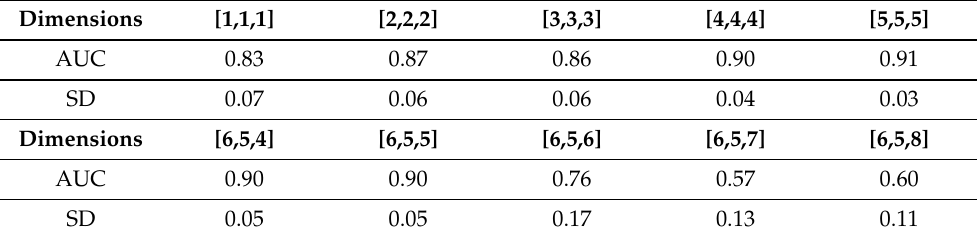
Table 6. Performance (mean AUC and standard deviation) of CMDA on tensors from the PTB dataset as the dimensions [ I , J , K ]